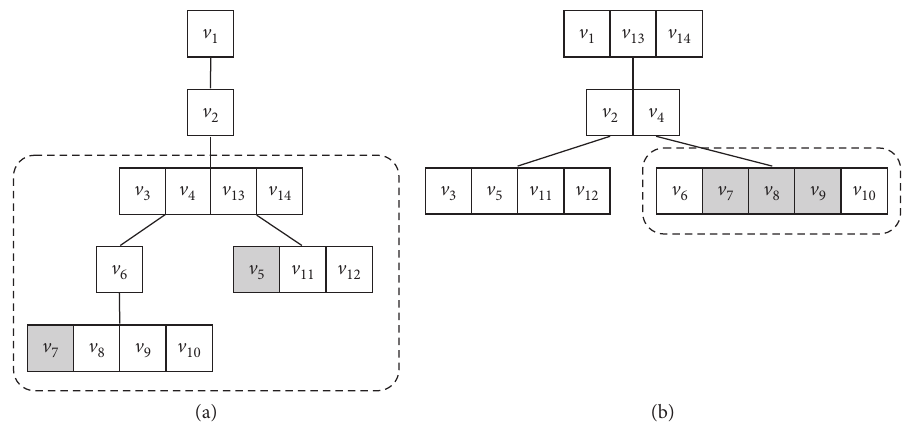
Figure 2: Index construction and query processing example: (a) k � 2 and (b) k �